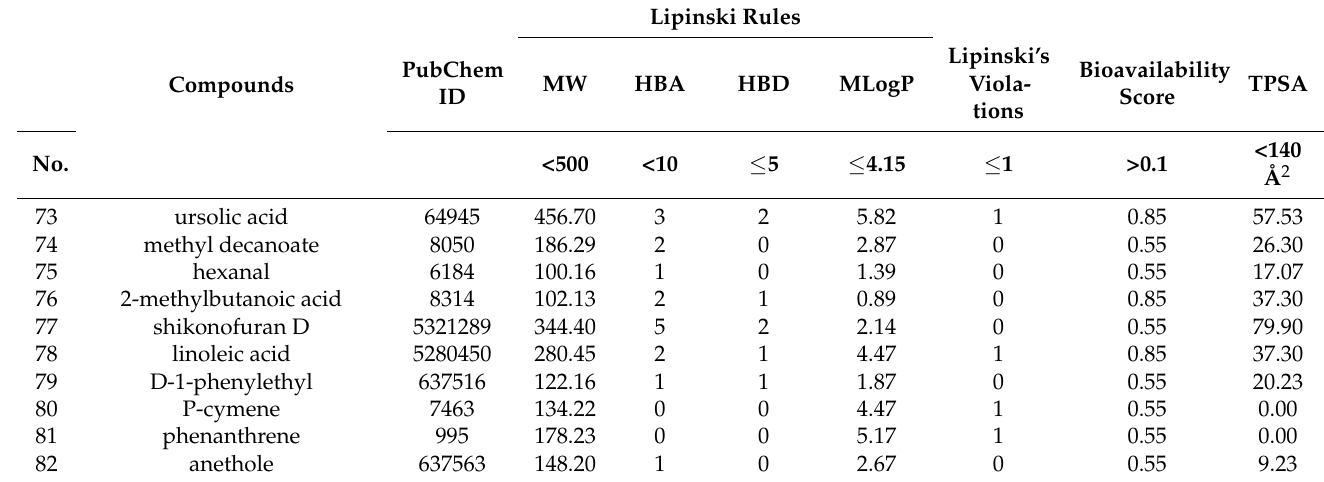
Figure 3. The final 19 targets between the 249 targets and 355 COVID-19 targets. 3.3. The Protein–Protein Interaction (PPI) Networks from 19 Targets In the PPI networks, the TNF target was considered to be the most significant target with the highest degree of value (15) (Table 2). Moreover, the 19 targets were closely in- terconnected with each other (19 nodes and 69 edges) (Figure 4). The TNF in the most central position was the most significant target in the PPI networks.